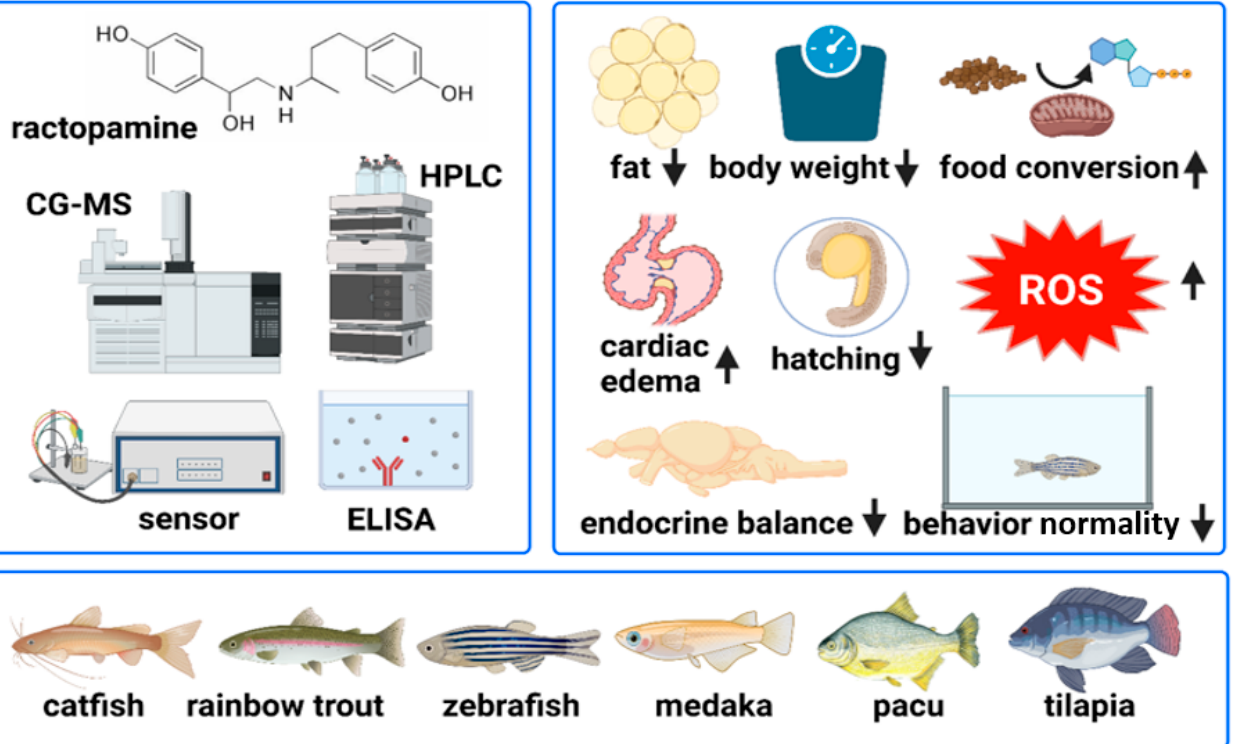
Figure 1. Summary of standard detection methods, aquatic animal models, and reported physiological alterations for ractopamine. The upper left panel summarizes the ractopamine chemical structure, standard detection instruments, and methods. The typical fish species used to study ractopamine’s beneficial and adverse effects are summarized in the bottom panel. The upper right panel summarizes the benefits and adverse effects of RAC administration in aquatic animals.